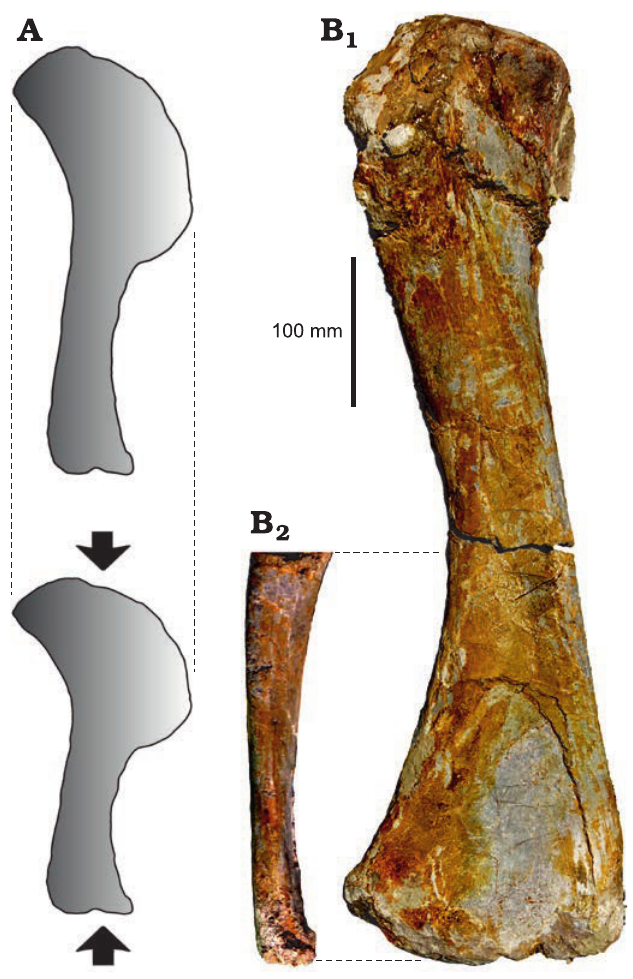
Fig. 2. Bone shortening due to plastic deformation. A . Compression may lead to substantial shortening along the axis of deformation. Note that no widening occurs. B . Right humerus of MSF 12.3 in posterior (B 1 ) and me - dial (B 2 ) views, showing extreme anteroposterior compression especially of the distal end. Despite this compression, the bone is not significantly widened in posterior view when compared with the relatively undeformed humerus of